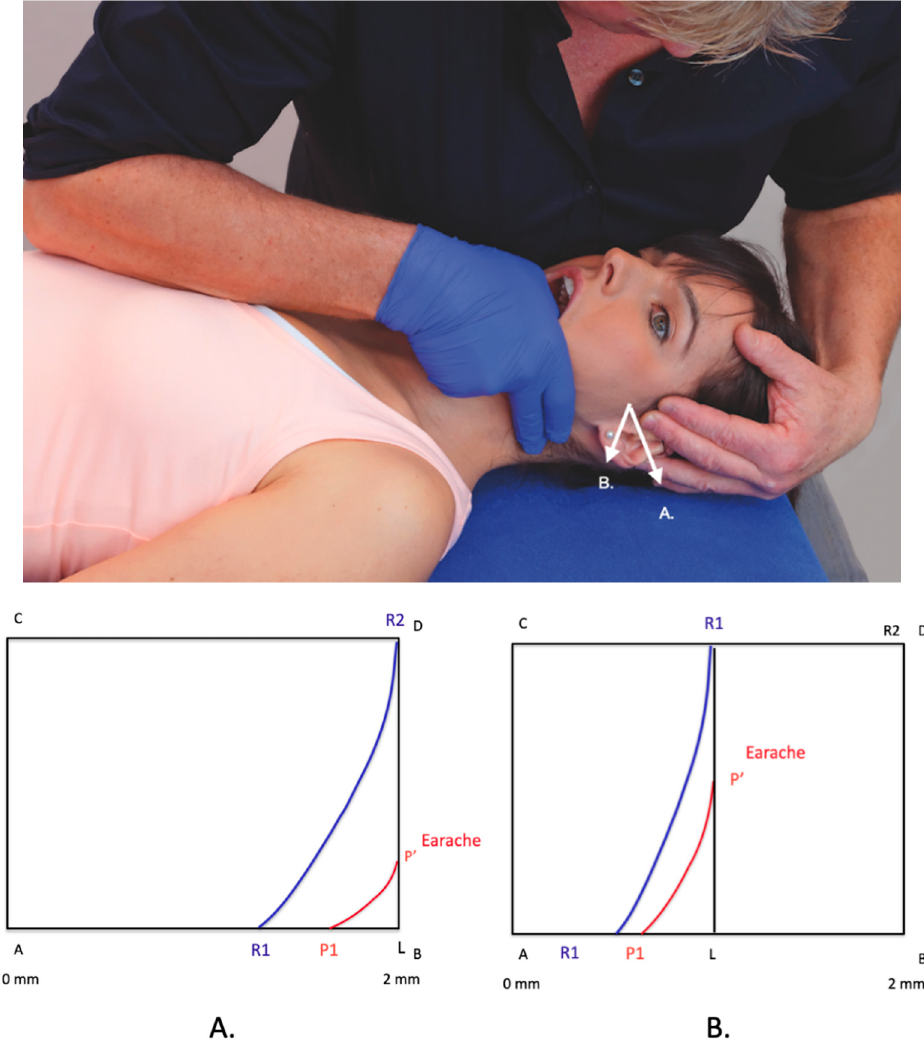
Figure 1. Accessory movement in the transverse sliding of the TMJ (temporomandibular joint) towards lateral ( A ) and with an angulation towards 30 ◦ posterior ( B ). Movement diagram A shows exponential curve (R1-R2) with no limitation when the average movement excursion is 2 mm. The reproduction of ear pain is minimal (P1-P”) (2 / 10 on a numerical pain rate scale, NPRS). Movement diagram B shows the angulated transverse to lateral, where R1-R2 is more than 50% restricted and the ear pain is stronger (6 / 10 NPRS), suggestive of lateral pterygoid muscle involvement. Reprinted with permission from Physikalisch Untersuchung von Dysfunktionen der kraniomandibulären Region. In: von Piekartz HJM (ed). 2nd edition. Kiefer-Gesichts-und Zervikalregion. Auflage: Thieme, 2015. Pg 212.